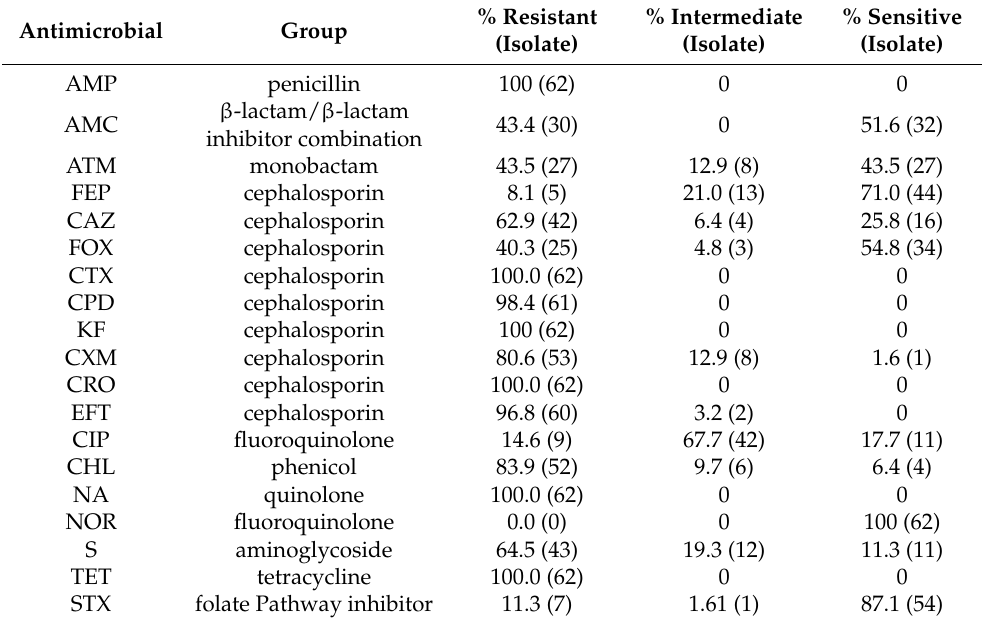
Table 1. Antimicrobial susceptibilities of 62 Salmonella Choleraesuis isolates from clinical specimens. % Resistant Antimicrobial Group